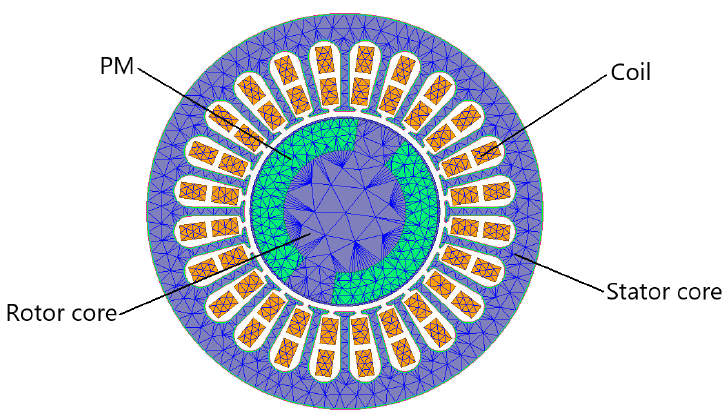
Figure 1. A 2D FEM analysis model of a high-speed permanent magnet synchronous motor .